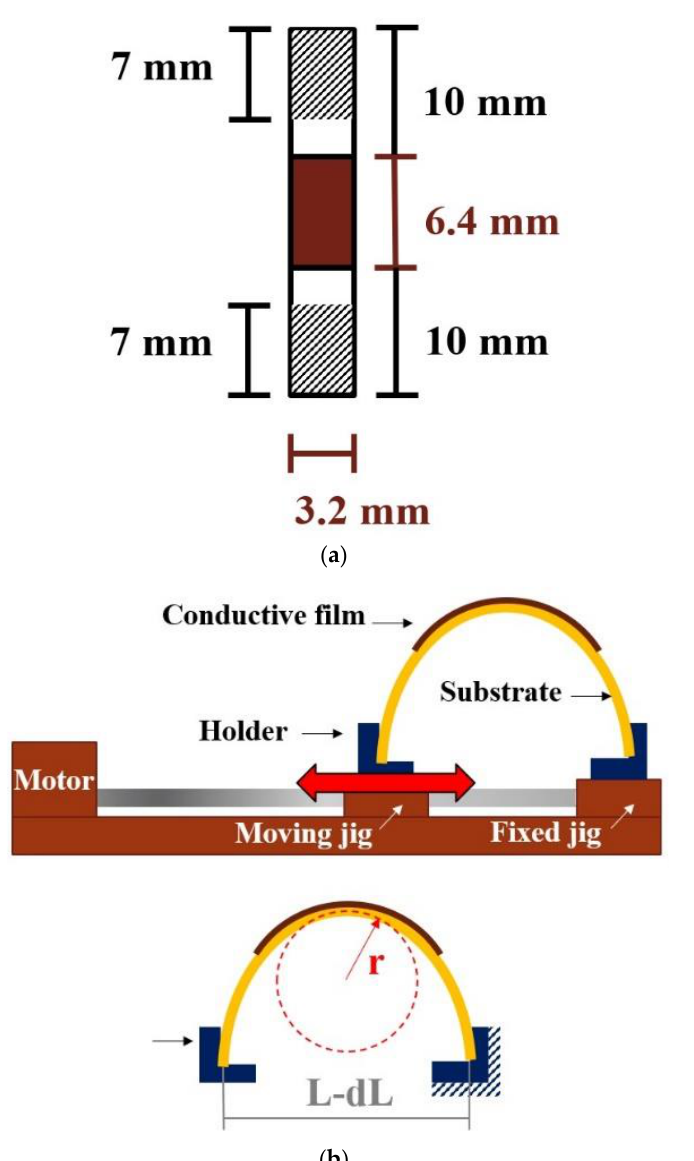
Figure 3. Schematic of the bending experiment: ( a ) test sample and ( b ) apparatus setup.